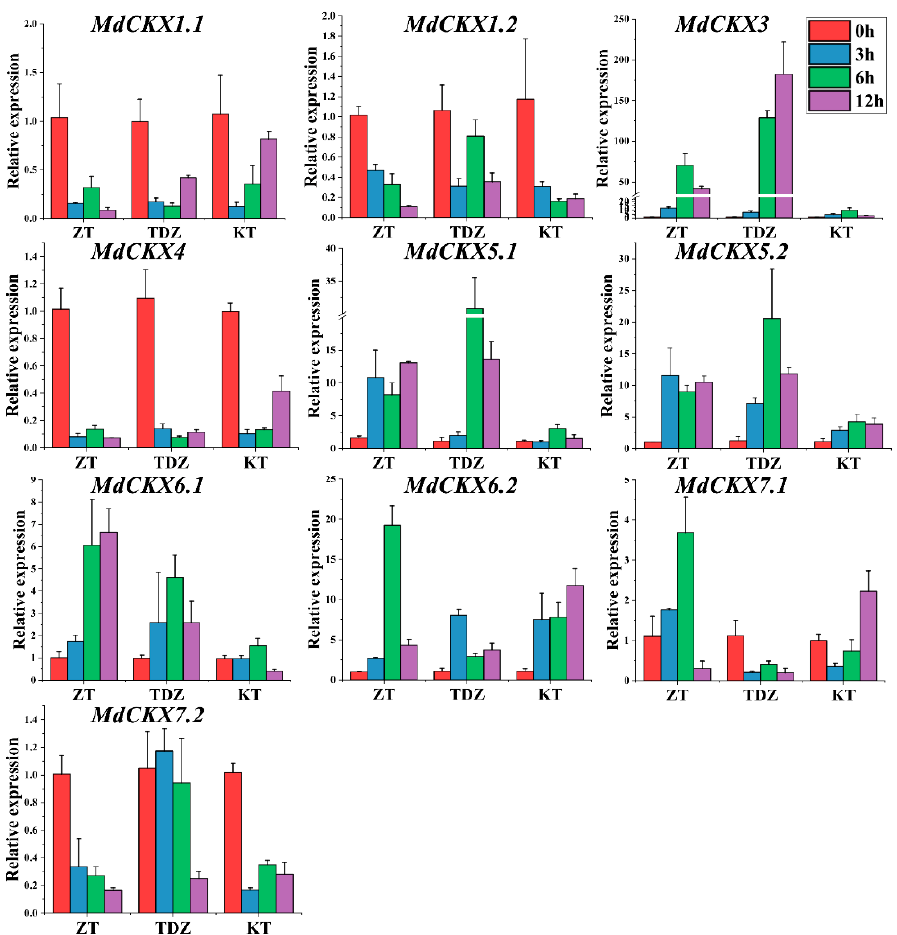
Figure 2. The gene expression patterns of MdCKX genes in response to CTKs (ZT, TDZ, and KT) in apple. Each panel shows that the expression levels of single MdCKXs under 100 µM trans-zeatin (ZT), thidiazuron (TDZ), and N6-Furfuryladenine (KT) for 0 h, 3 h, 6 h, and 12 h. Error bars represent standard deviation (SD).